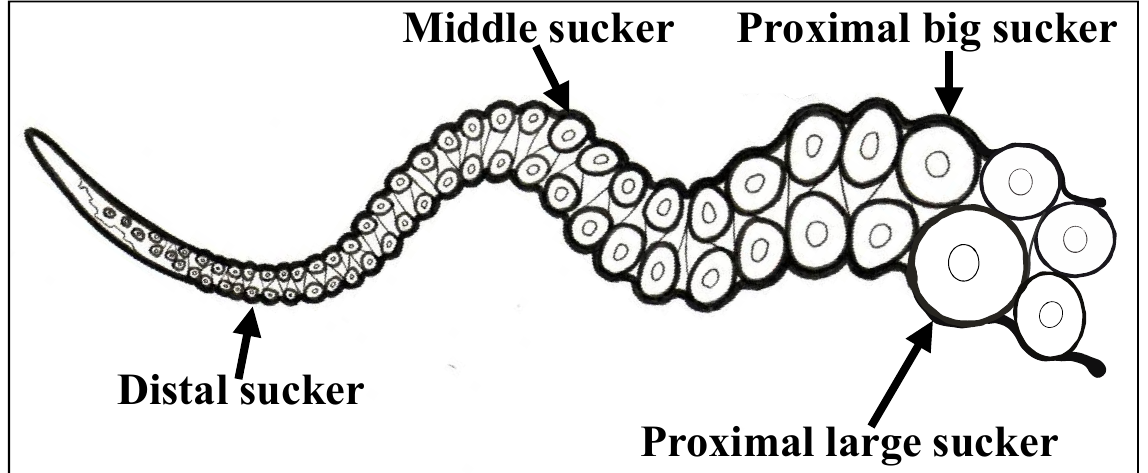
Figure 1. Image description of four sucker types: proximal big, proximal large, middle, distal. To localize the expression of Ov GRK1 we performed whole mount in situ hybridi- zation on suckers from the L1 arm. The dissected suckers were fixed overnight in 4% PFA (4% Para-formaldehyde in PBS, pH 7.4) at 4 ◦ C. Fixed tissues were dehydrated in a graded methanol series (25% MeOH; 50% MeOH; 75% MeOH and 100% MeOH) with 1X